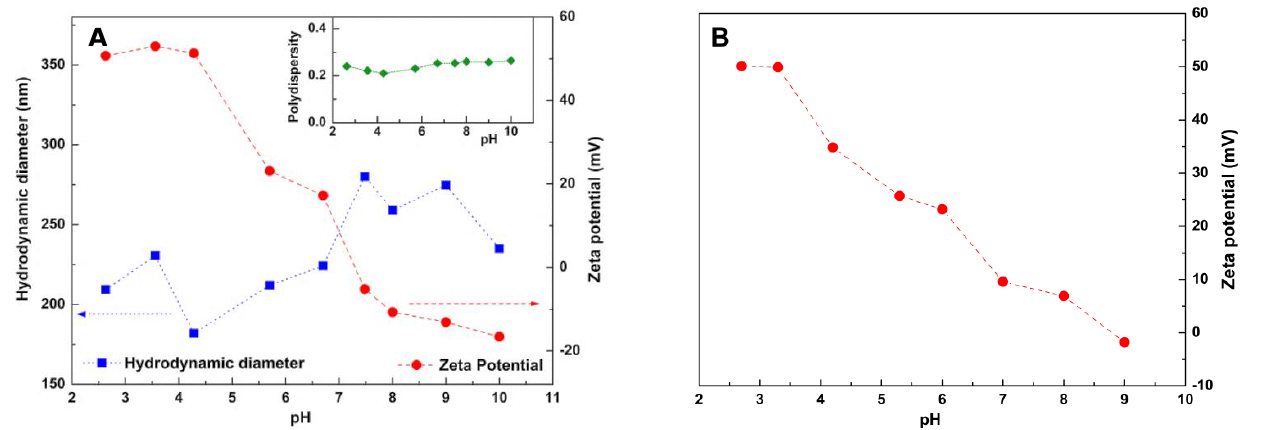
Figure 3. ( A ). Hydrodynamic diameter and zeta-potential values of chitosan nanostructures, at different pH values. Inset: Polydispersity index. ( B ) . Zeta-potential values of chitosan/silver nanocomposites in aqueous solution at different pH values.